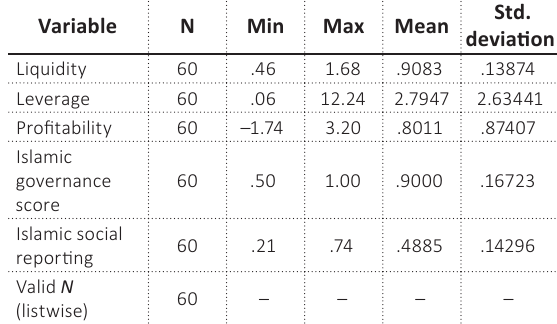
Table 1. Variable description